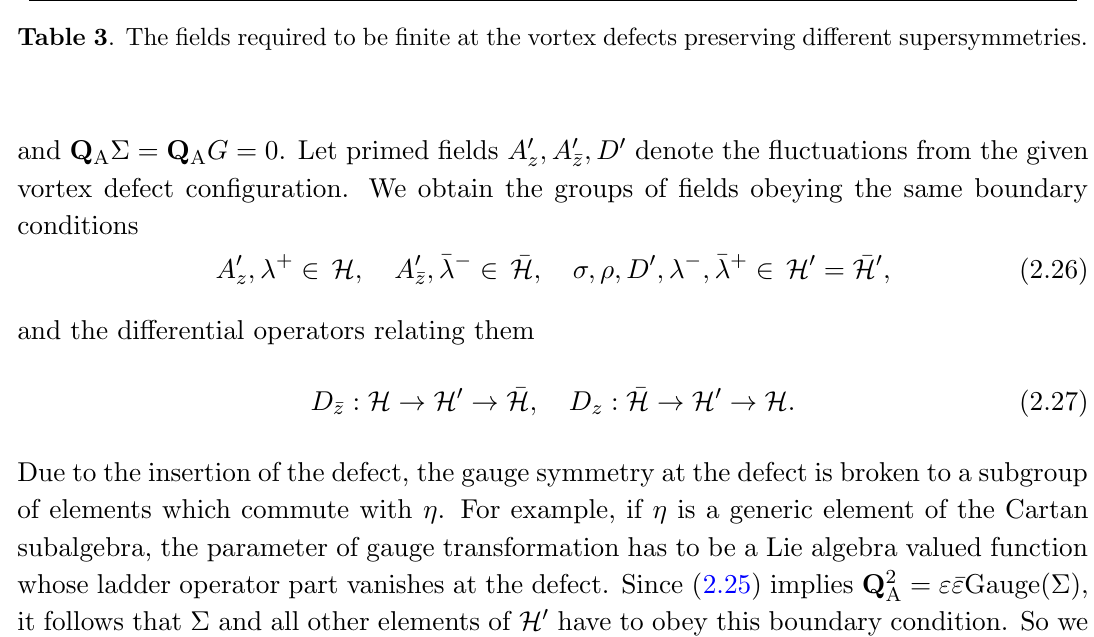
Table 3 . The (cid:12)elds required to be (cid:12)nite at the vortex defects preserving di(cid:11)erent supersymmetries.